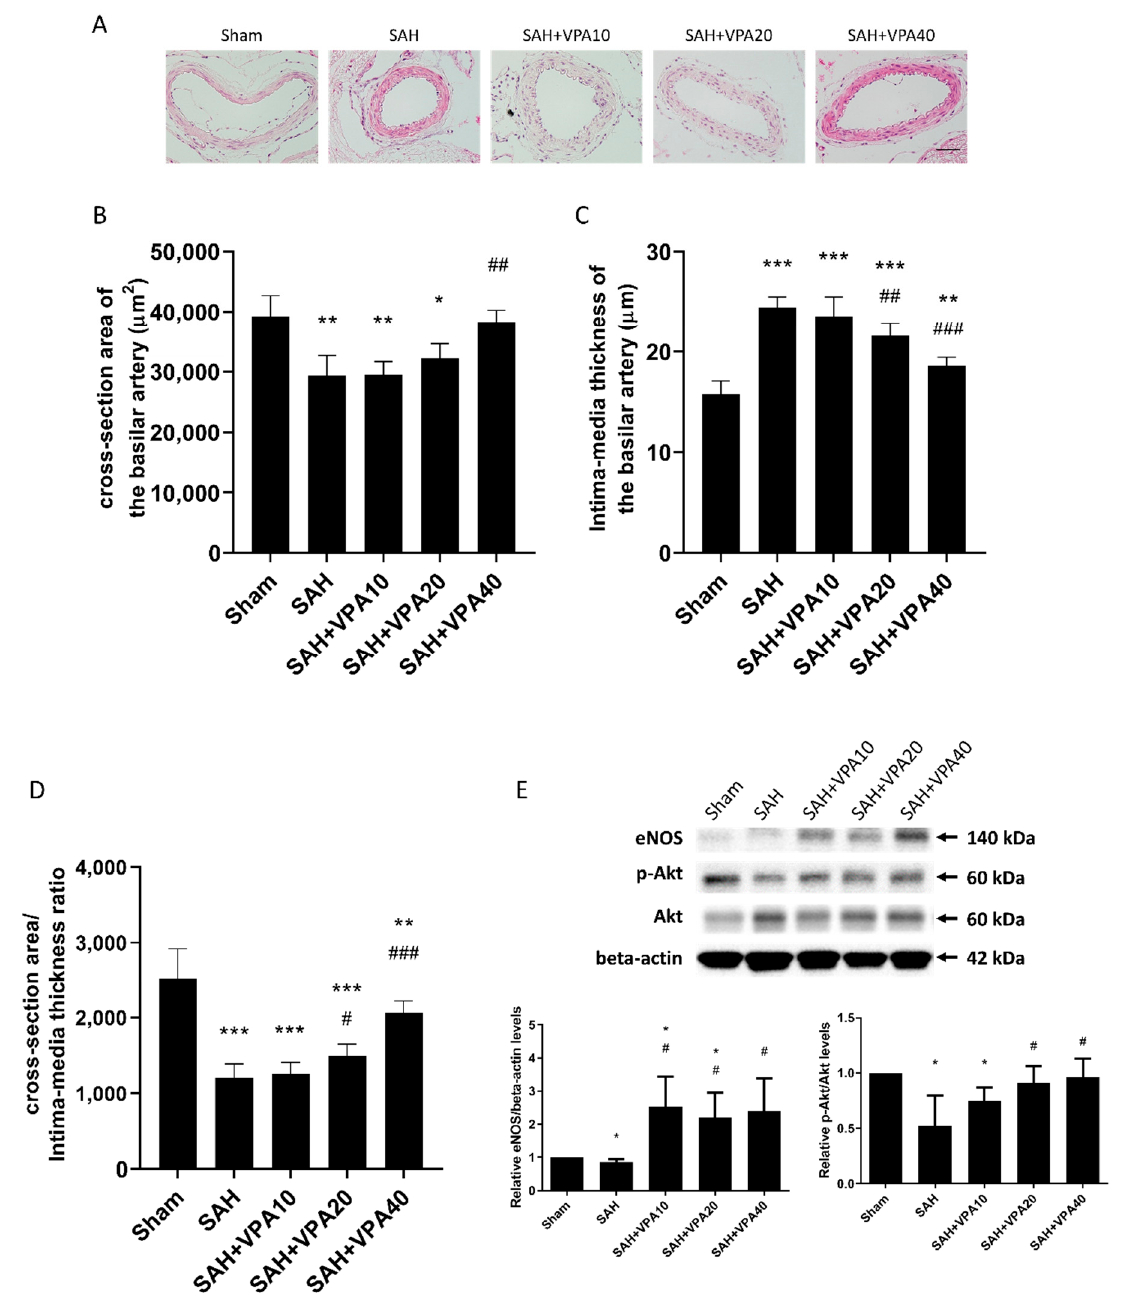
Figure 1. VPA ameliorated vasospasm in SAH rats. Comparison of cross-sectional areas of the lumen in basilar arteries (BA). ( A ) Representative cross-sectional micrographs of BA. ( B ) Quantification of cross-sectional areas of the lumen. ( C ) Quantification of intima-media thickness. ( D ) Quantification of the ratio of cross-sectional areas to the intima-media thickness. All values are expressed as mean +SEM ( n = 5–7); * p < 0.05. ** p < 0.01, *** p < 0.001 in comparison with the sham group; # p < 0.05. ## p < 0.01, ### p < 0.001 in comparison with SAH group (scale bar = 50 μ m) ( E ) Top panel: representative expression of eNOS, Akt and phospho-Akt protein of BA. Beta-actin was used as control. Lower panel: quantification of relative eNOS and p -Akt activity. All gels were run in the same experimental conditions ( n = 3–4). * p < 0.05, compared with the sham group, # p < 0.05, compared with the SAH